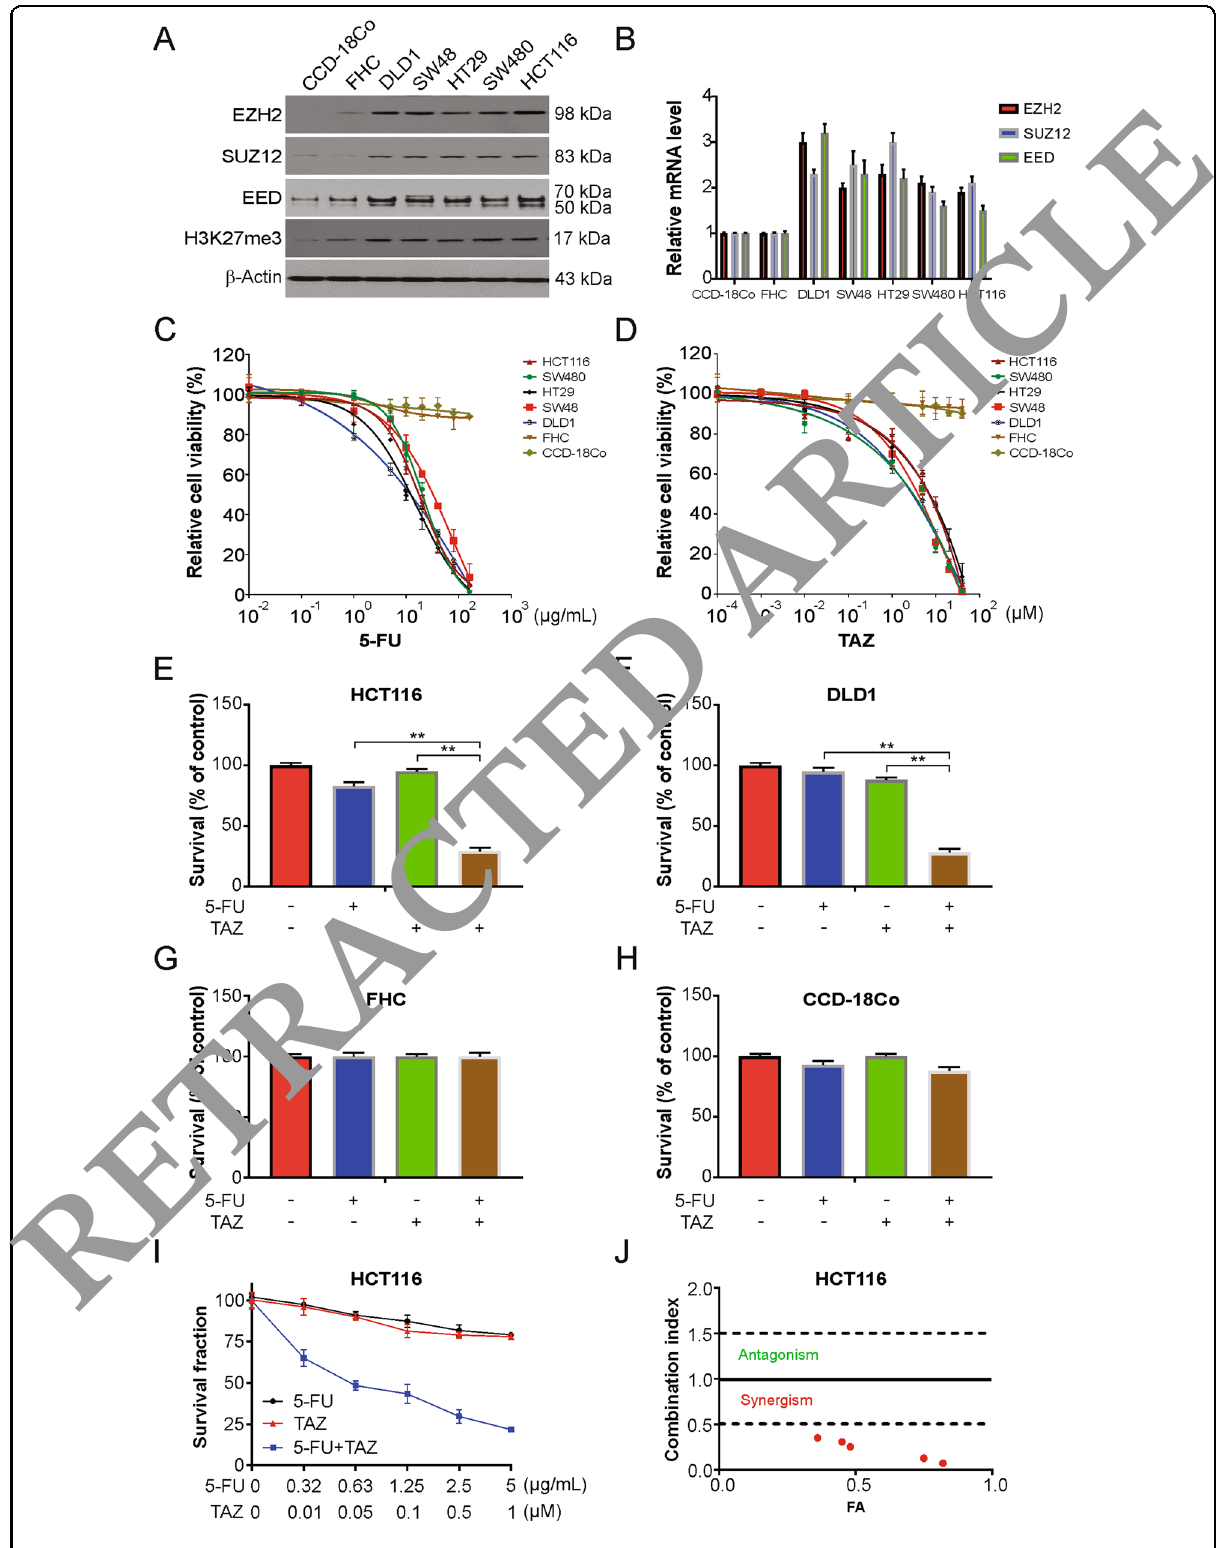
Fig. 1 (See legend on next